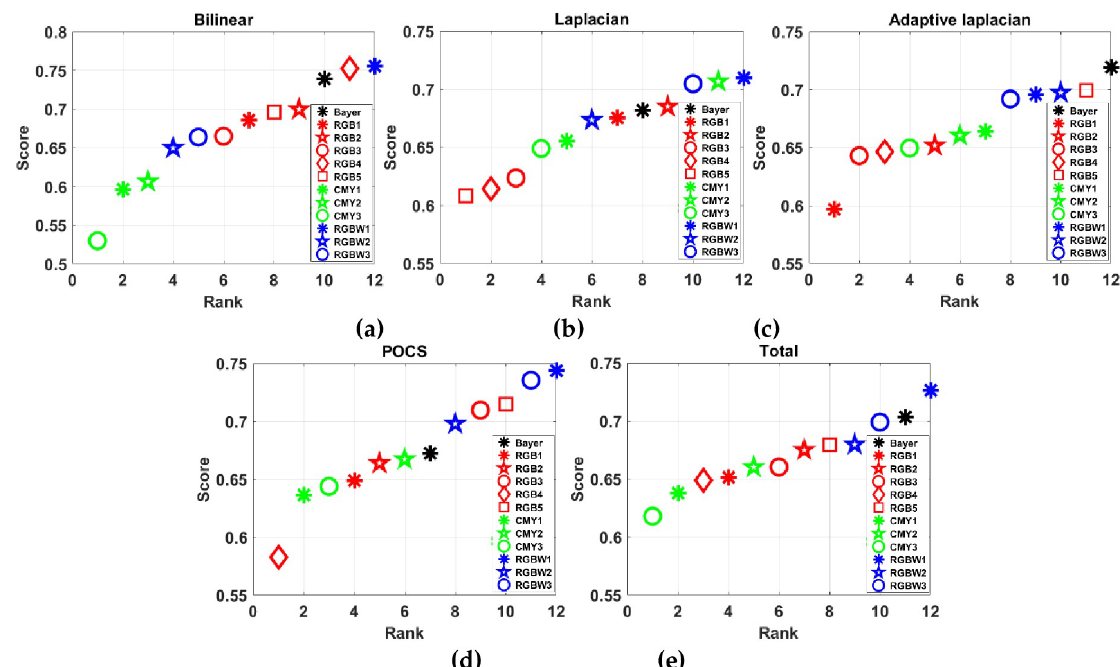
Fig 17. CFA ranks for (a) blinear, (b) laplacian, (c) adaptive laplacian, (d) POCS, and (e) total demosaicing methods. demosaicing, and RGB5 for POCS demosaicing have the highest number of red box (best met- ric-score). Also, regardless of demosaicing methods, Bayer, RGB1~RGB5, CMY1~CMY3, and RGBW1~RGBW3 CFA have seven, two, zero, one, three, three, one, one, four, seven, two, and